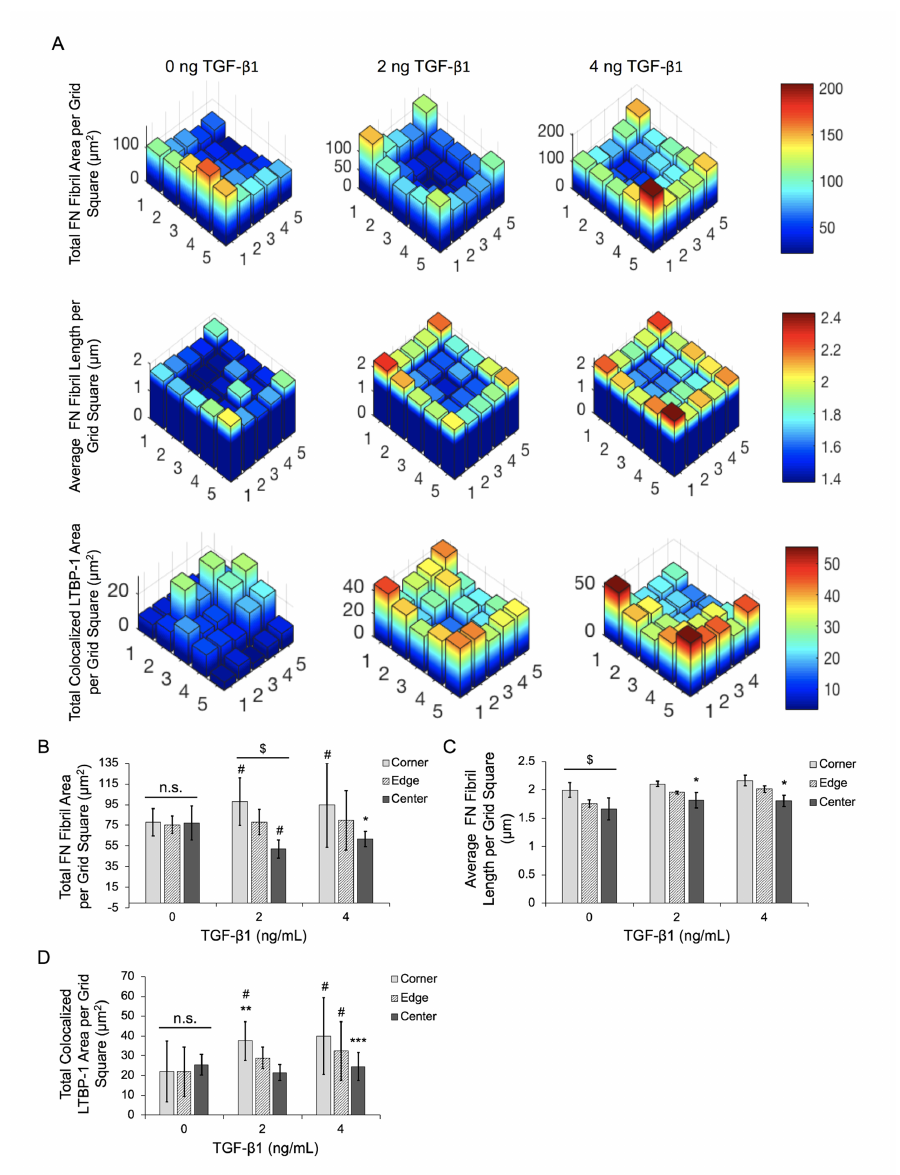
Figure 5. Increasing TGF- β 1 concentration induces spatial gradients of FN fibril area, FN fibril length, and LTBP-1 colocalization with FN fibrils in MCF10A square islands. ( A ) Data from cell islands was partitioned into a 5 × 5 grid. Representative frequency maps of total FN fibril area per grid square, average FN fibril length per grid square and total colocalized LTBP-1 per grid square are shown. Grid regions were separated into corner, edge, and center regions for quantification of spatial gradients. ( B ) Total FN fibril area per grid square based on TGF- β 1 concentration and square location. ( C ) Aver- age FN fibril length per grid square based on TGF- β 1 concentration and square location. ( D ) Total LTBP-1/FN colocalization area per grid square based on TGF- β 1 concentration and square location. N = 3 experimental replicates, n > 10 islands per experiment for each condition. n.s., not significant, * p ≤ 0.05 significantly different from both edge and corner within given concentration, ** p ≤ 0.05 significantly different from both edge and center within given concentration, *** p ≤ 0.05 significantly different from only corner within given concentration, $ p ≤ 0.05 significantly different from all other locations within given concentration, # p ≤ 0.05 significantly different from corresponding location in 0 ng/mL TGF- β 1. p -values based on Bonferroni’s post-hoc multiple comparisons test following Two-way